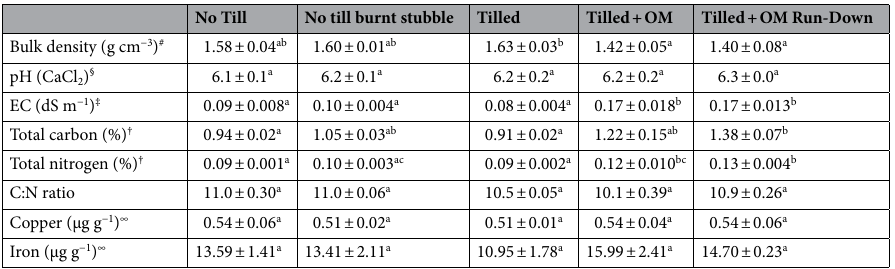
Table 2. Properties of field organic matter treatments (0–10 cm depth) at start of present study, 7 years after treatments were imposed. Values are a mean of three field replicates ± standard error of the mean. Organic matter treatments with the same letter are not significantly different ( p > 0.05). OM organic matter. # Bulk density determined using the intact core method with 3 cores of 7.35 cm diameter by 10 cm depth 66 . § pH was determined on air-dry soil in 0.01 M CaCl 2 with a 1:5 soil:extract ratio, after shaking for 1 h, and while stirring the soil suspension 67 . ‡ Electrical conductivity was determined on air-dry soil in water with a 1:5 soil:water ratio 67 . † Total carbon and nitrogen were determined by high-temperature combustion of finely ground